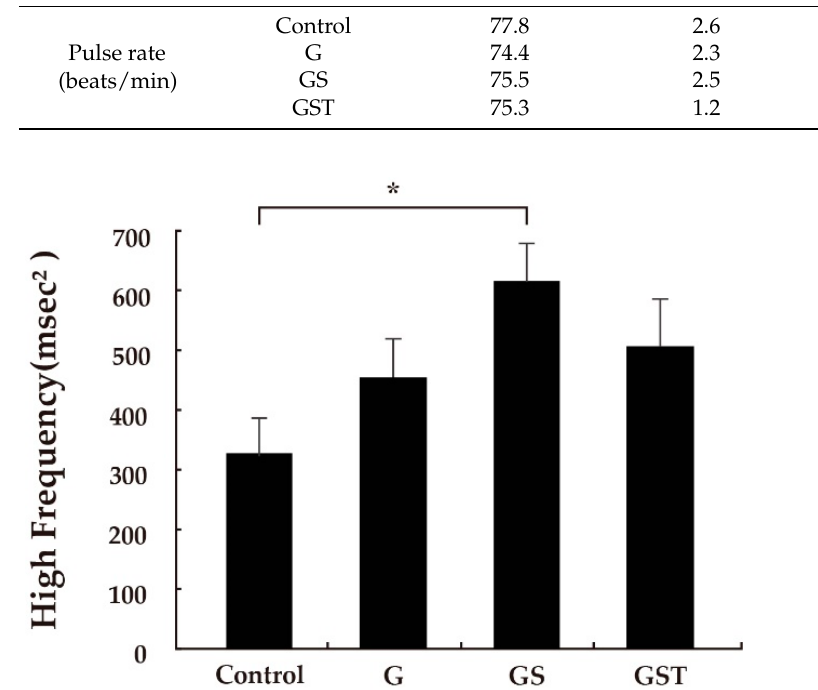
Figure 2. Values of high frequency power when viewing the four rooftop images. Control: no vegetation with concrete floor; type G: grass vegetation; type GS: grass-shrubs vegetation; type GST: grass-shrubs-trees vegetation; n = 15, mean ± SE; *, p < 0.05.